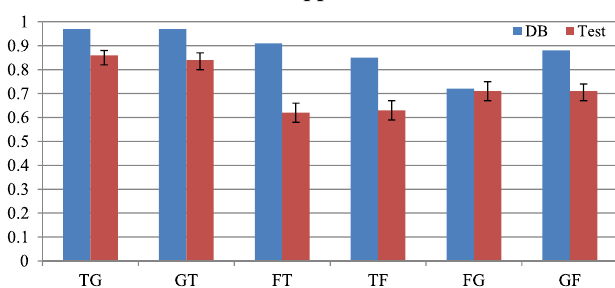
FIG. 11. Comparison of the data from De Bock, Van Dooren, and Verschaffel [15] (DB) and our data (Test) for the PP function type for each of the representational